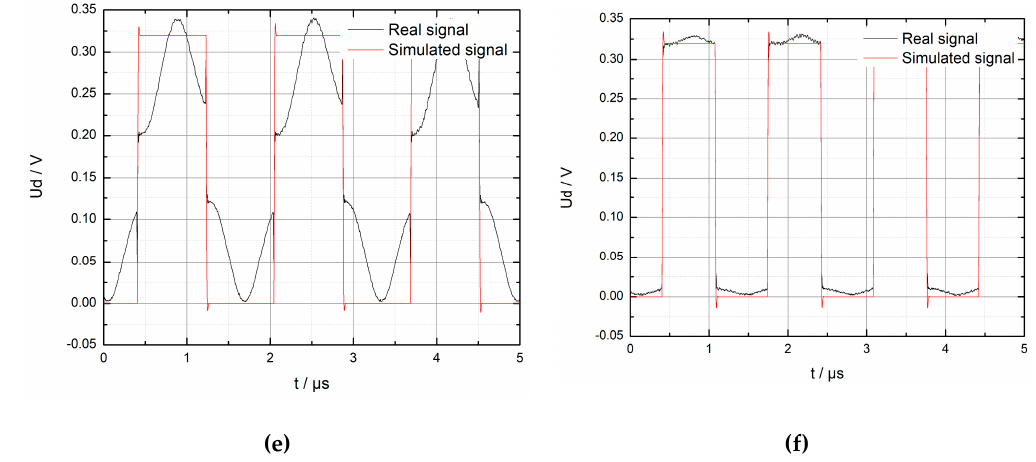
Figure 2. Real and simulated photodetector signal for Pockels cell with 3 mm × 3 mm × 25 mm beta barium borate (BBO) crystal at frequencies of high voltage pulses: ( a ) 150 kHz; ( b ) 180 kHz; ( c ) 205 kHz; ( d ) 445 kHz; ( e ) 600 kHz; ( f ) 750 kHz.